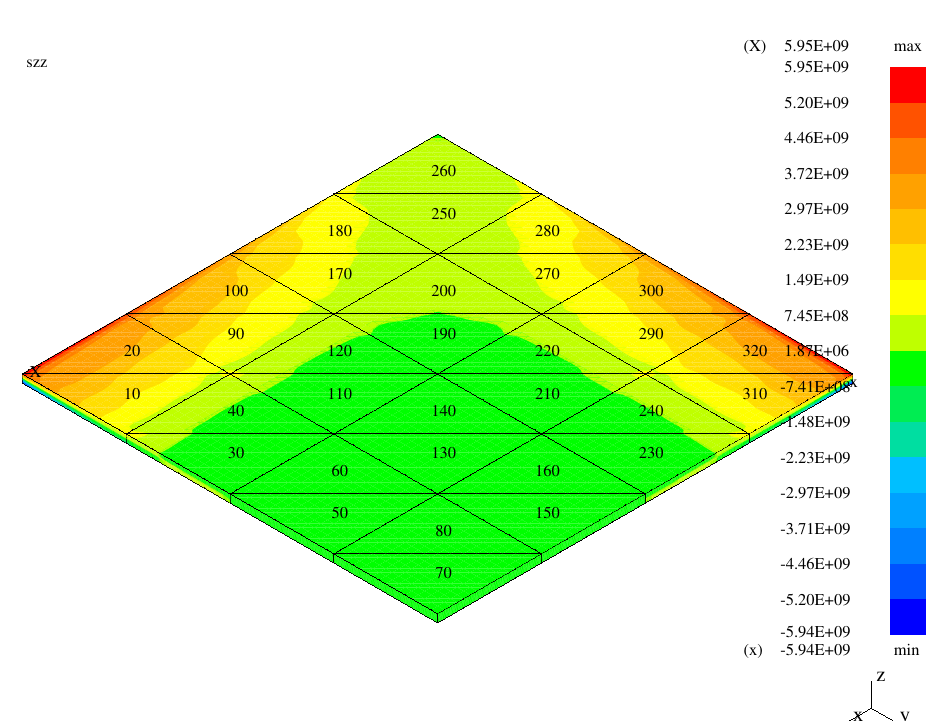
Figure 13. Transverse stress—the bent plate with the enhanced transition